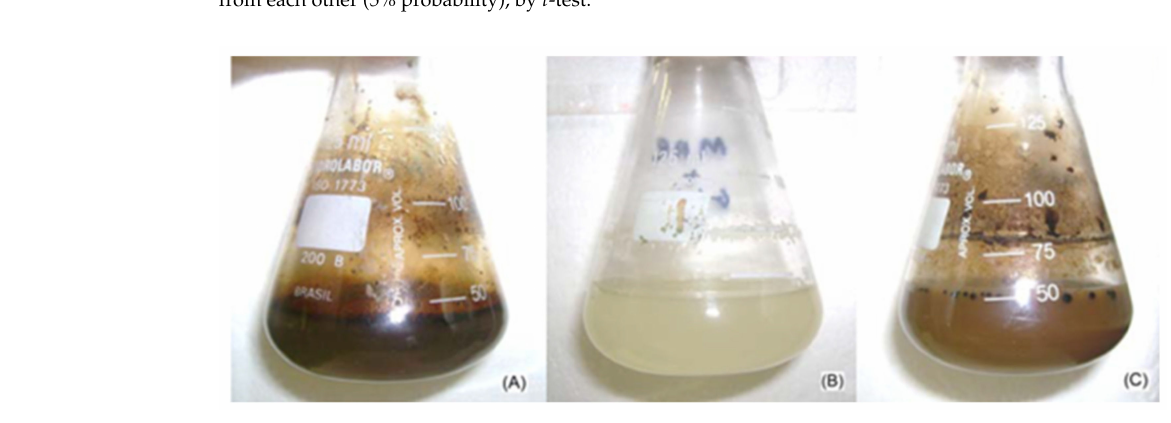
Figure 2. Images from the flasks after 120 h of Y. lipolytica IMUFRJ 50682 growth in ( A ) seawater